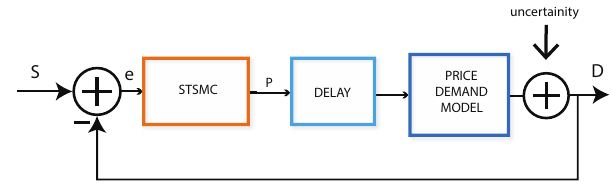
Figure 8. Simulink block diagram for the proposed